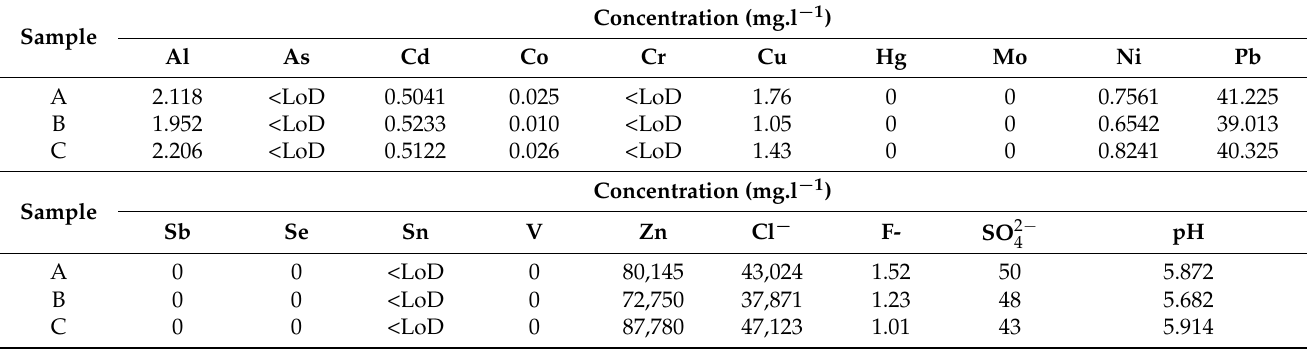
Table 3. Results of Leachability